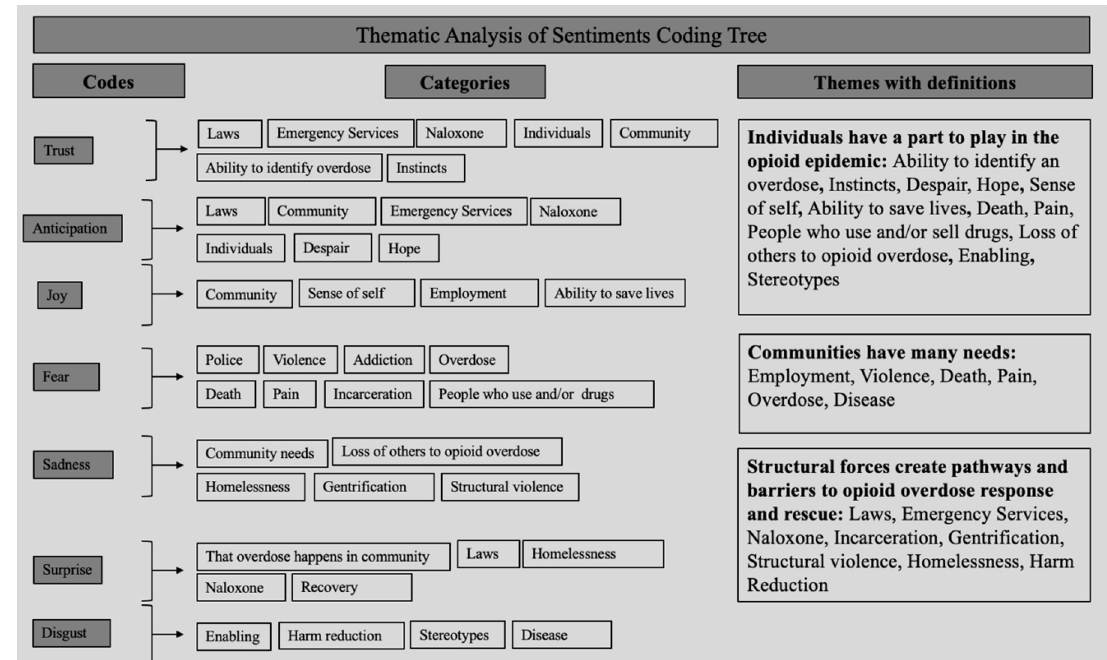
Figure 2. Thematic Analysis of Sentiment Coding Tree; Created by the authors as a part of the iterative thematic analysis process described above. This process resulted in three primary themes: